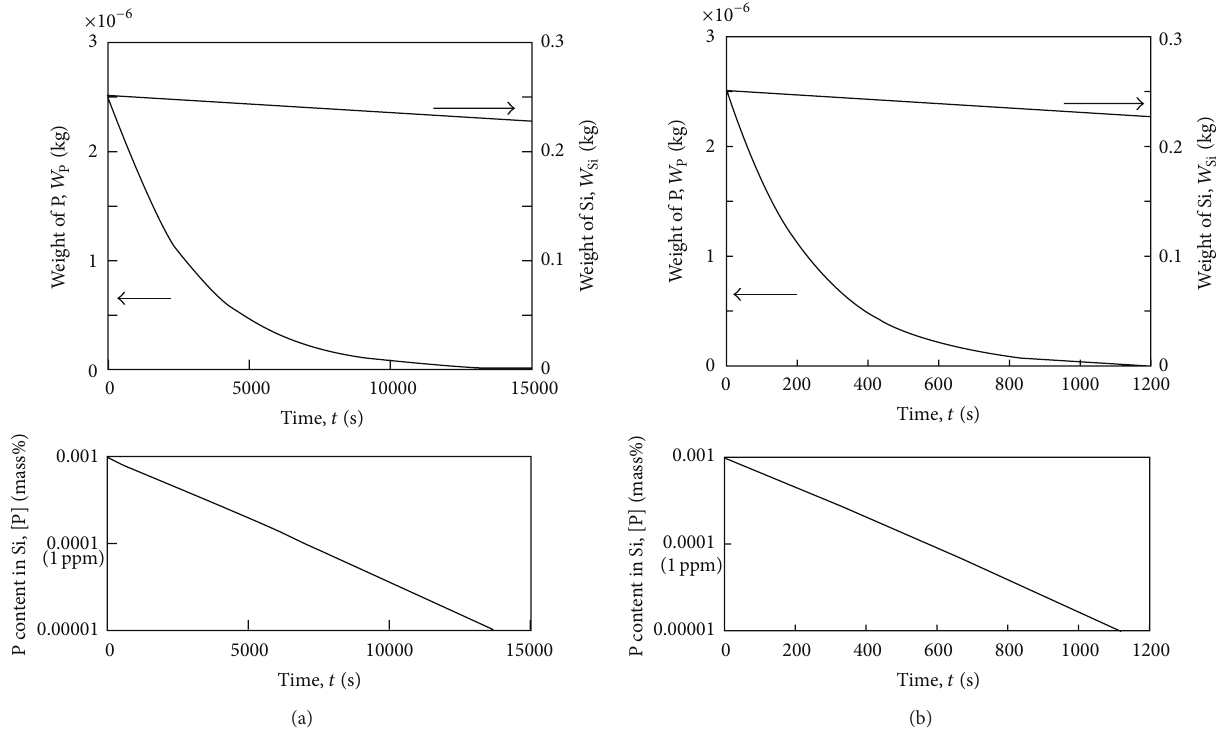
Figure 5: Estimated changes in 𝑊